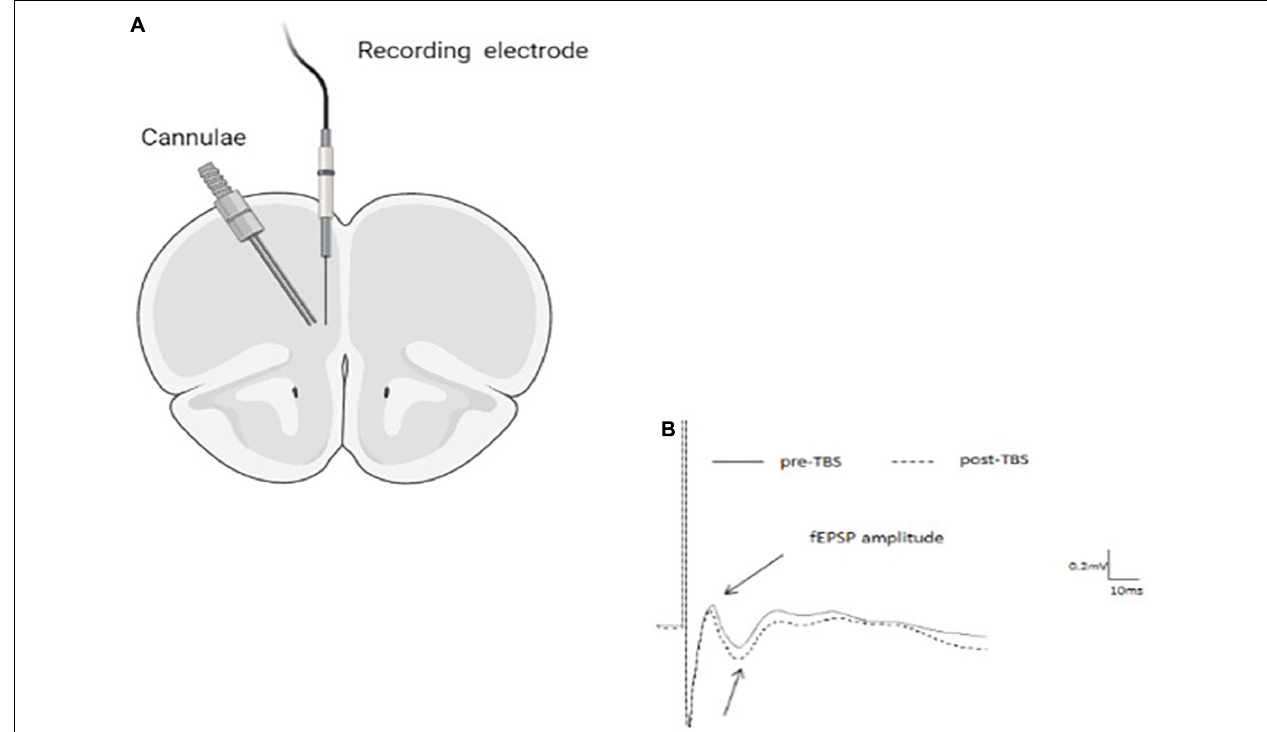
FIGURE 1 | (A) Schematic drawing indicating cannula and recording electrode positions within the infra-limbic medial prefrontal cortex (IL-mPFC). (B) Representative average waveforms before and after TBS.